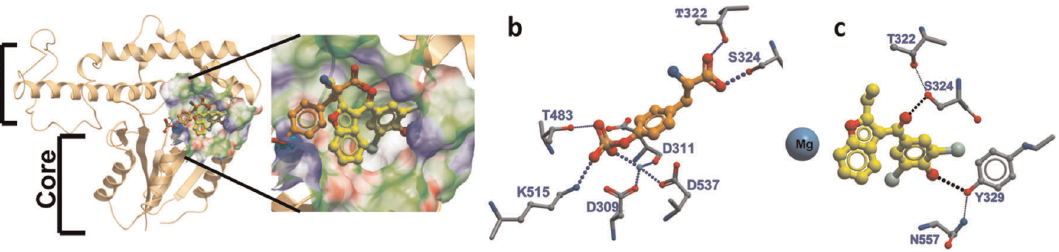
Figure 3. Binding modes of Benzbromarone and the substrate mimic phosphotyrosine differ. ( a ) In docking experiments phosphotyrosine (gold) and compound 1 (yellow) bind at the interface of the cap and core subdomains of the catalytic ED domain of EYA3. ( b ) Phosphotyrosine coordinates the active site metal ion and makes hydrogen bonds with residues in all three conserved motifs in the EYAs. ( c ) Docked conformation (ICM Score 2 24.8) of compound 1 docked into the active site of EYA3(ED). The conformation shown here was obtained in multiple docking experiments conducted with different starting conformations for the ligand. Compound 1 inserts its dibromo-phenol group into a hydrophobic cavity adjacent to the phosphotyrosine binding site and is anchored by a hydrogen bond with Tyr 329. The carbonyl group forms a hydrogen bond with Ser 324. Compound 1 is not within bonding distance of the metal ion.